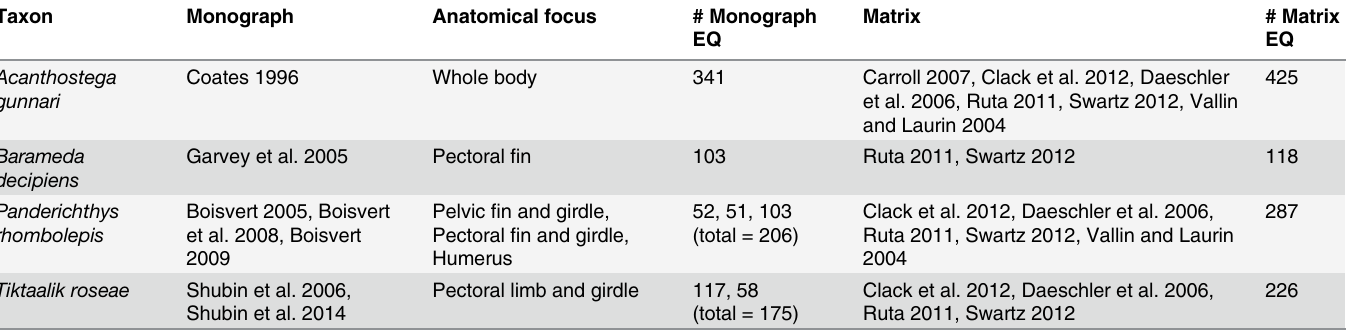
Table 1. List of monographic and matrix publications used in this analysis along with anatomical focus of the study and the number of fin or limb and girdle EQs (phenotypes) associated with each taxon.